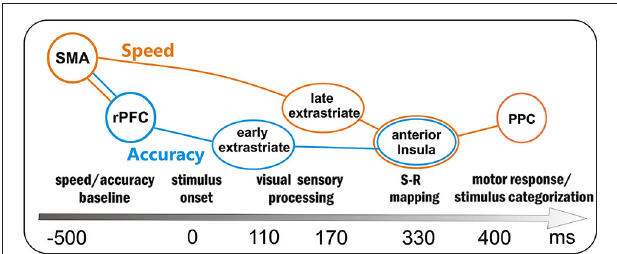
FIGURE 5 | Sketch of the processing in the preparation-perception- action cycle and associated brain areas as a function of time (not scaled) . Obviously the same brain areas were involved in both speed- (orange) and accuracy (blue)- processing; however, the activity of some areas was more affected by either one or the other condition: the orange and blue lines depict the two main flows within speed and accuracy systems. SMA = supplementary motor area, rPFC = right prefrontal cortex, PPC = posterior parietal